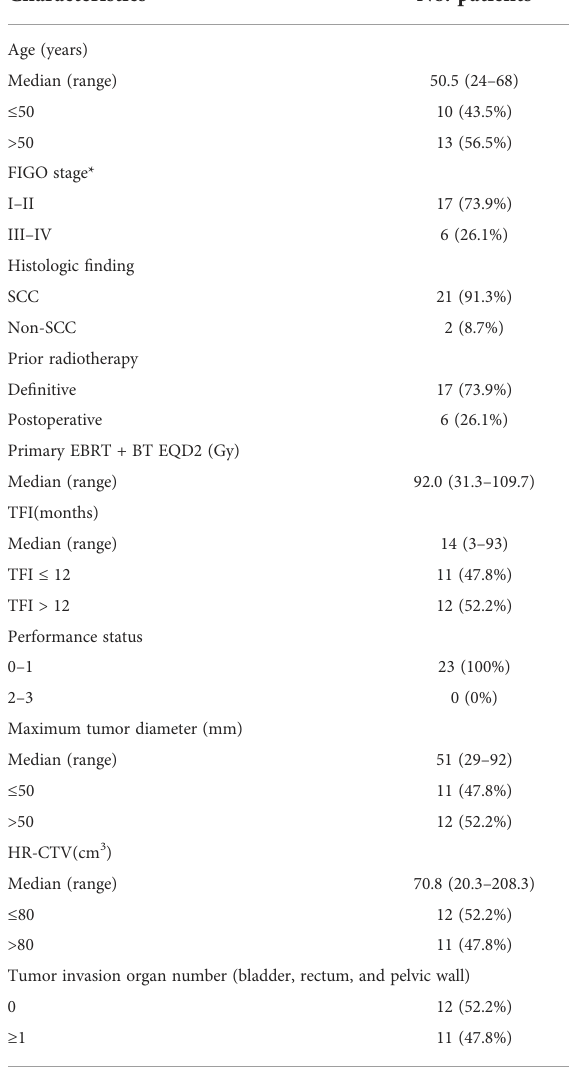
TABLE 1 Baseline characteristics of involved patients (N =